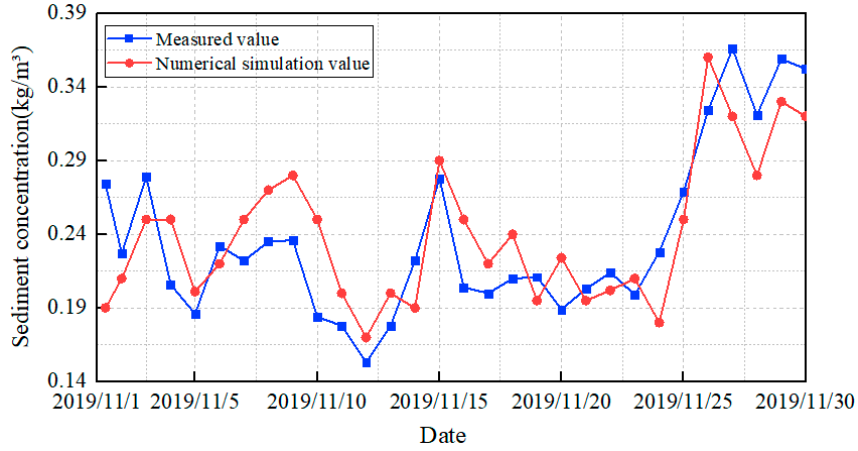
Figure 4. Verification of sediment concentration at the